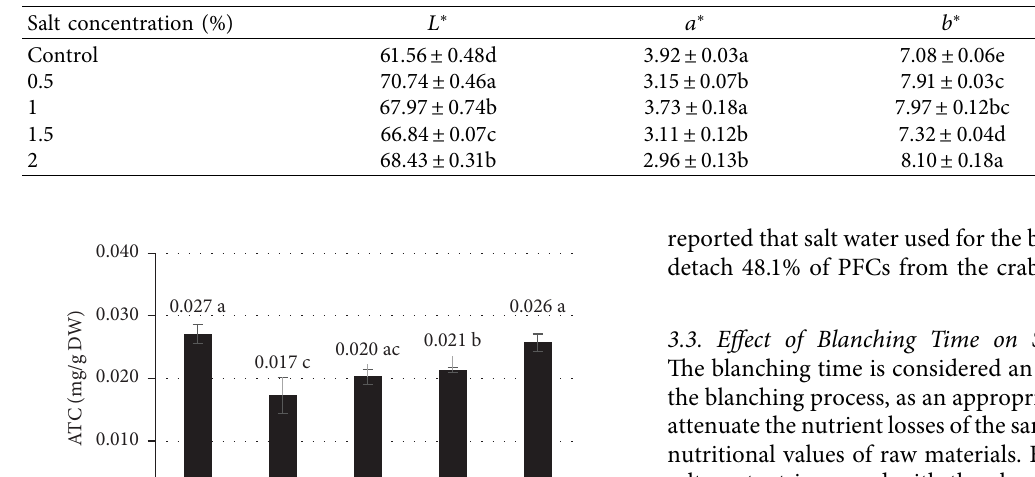
Table 1: Efect of salt concentration on color.